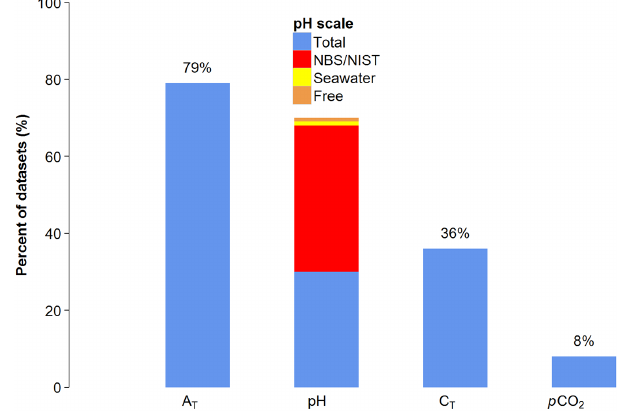
Figure 7. Variables of the seawater carbonate system reported in the data